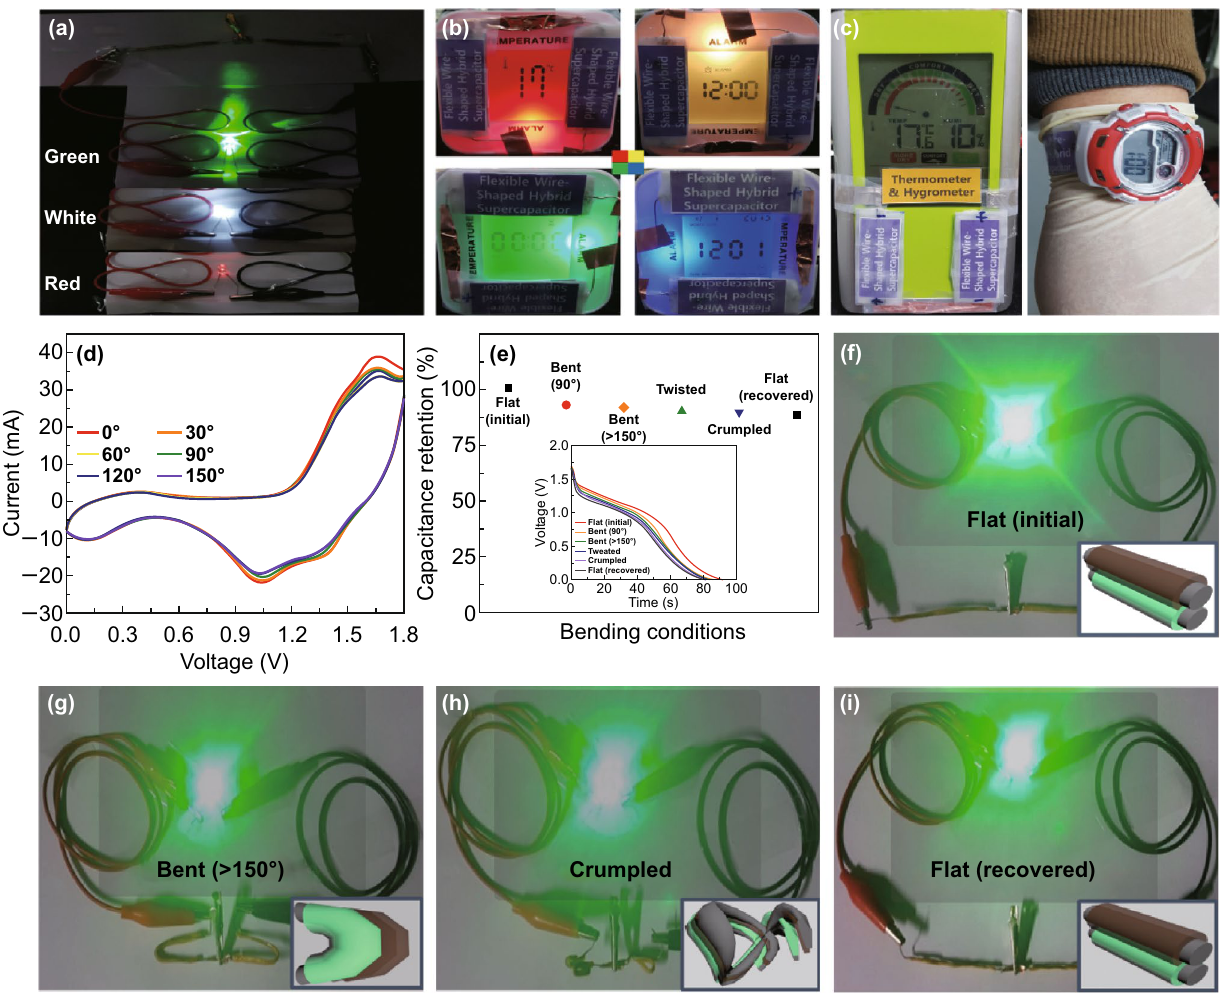
Fig. 4 a – c Various examples of electronic devices powered by two wire‑type hybrid supercapacitors in series: a digital image of a the green, white, and red LED indicators, b LCD devices with various colors, and c a thermometer and hygrometer and a wearable electrical watch. d CV curves at a scan rate of 50 mV s −1 and e capacitance retention (the inset is the galvanostatic discharge curves at a current density of 5 A g −1 ) of single wire supercapacitor when subjected to various bending conditions. f – i Digital camera images of two wire‑type supercapacitors connected in series at different bending conditions: f flat, g bent at > 150°, h crumpled, and i recovered